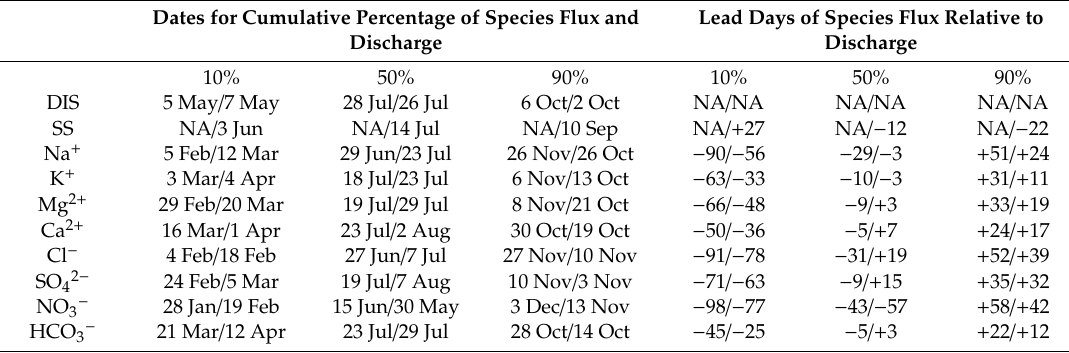
Table 7. Comparison of the dates of cumulative percentage distribution of major ion and suspended sediment (SS) fluxes with discharge (DIS) at the Hailuogou basin over two melt seasons in 2008 (before the slash) and 2013 (after the slash). Negative and positive values denote the days for solutes and SS later and earlier than discharge delivery, respectively. N / A denotes data are not